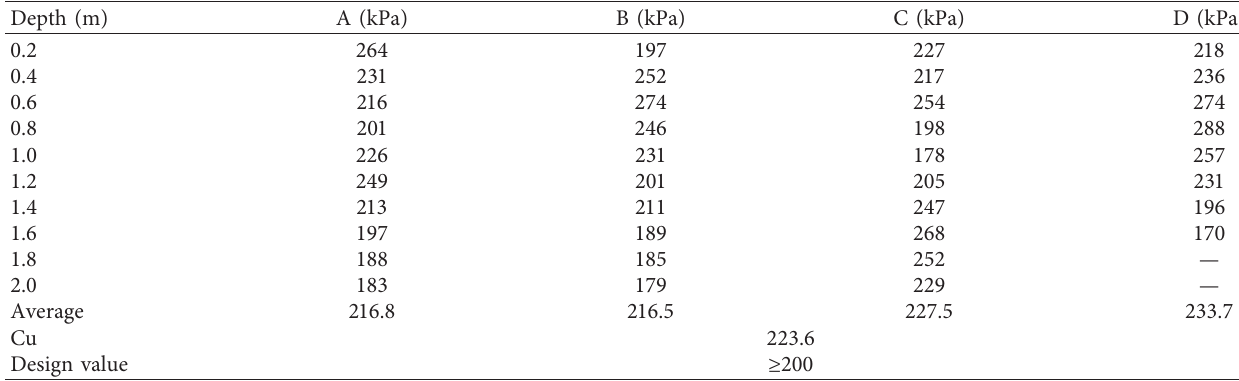
Table 7: Vane shear strength (Cu) of subgrade in different depths.